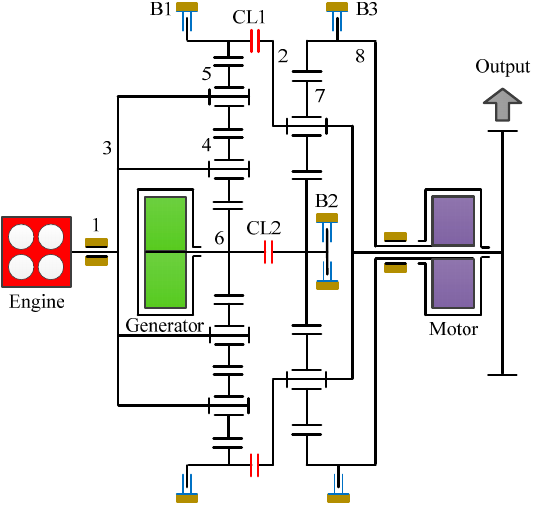
Figure 10. A novel series-parallel hybrid transmission.